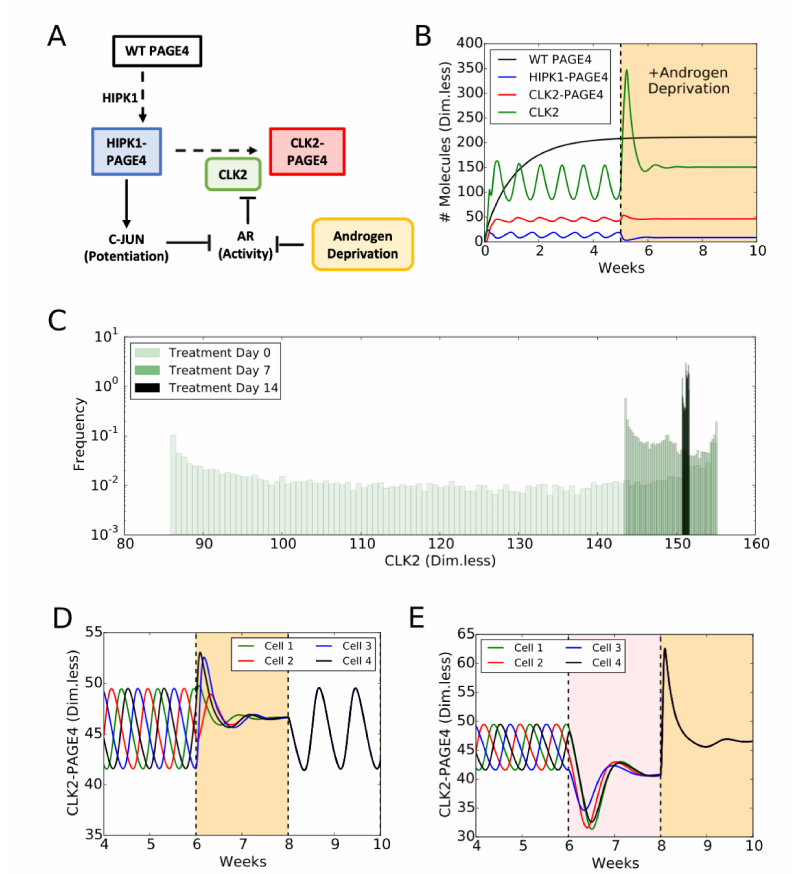
Figure 5. PAGE4 conformational switching gives rise to cell phenotypic oscillations which are suppressed by Androgen Deprivation treatments. ( A ) The PAGE4 phosphorylation circuit and its connection with androgen receptor (AR) activity. Wild-type PAGE4 is double-phosphorylated at two residues by HIPK1 kinase, and HIPK1-PAGE4 is hyper-phosphorylated by the CLK2 kinase. CLK2 is downregulated by AR, which in turn is inhibited by HIPK1-PAGE4 via the intermediates c-Jun. Androgen Deprivation treatment is introduced as an inhibitory signal on AR activity. ( B ) Temporal dynamics of the cellular level of WT PAGE4, HIPK1-PAGE4, CLK2-PAGE4 and CLK2. Without androgen-deprivation therapy (ADT), the oscillatory behavior exhibits a period of approximately one week (left area without shading). ADT (orange-shaded area) quenches oscillations within approximately two weeks. WT PAGE4, HIPK1-PAGE4, CLK2-PAGE4 and CLK2 are represented in dimensionless units. ( C ) Distribution of CLK2 intracellular levels in a simulated cohort of 10,000 prostate cancer (PCa) cells. In the absence of treatment, the distribution of CLK2 levels is broad (“Day 0” case). One week of treatment considerably shrinks the distribution (“Day 7” case). After two weeks of treatment, all cells have a similar level of CLK2 (“Day 14” case). ( D ) Temporal dynamics of CLK2-PAGE4 in four initially unsynchronized cells under intermittent ADT. The orange shading represents the periods of ADT. ( E ) Temporal dynamics of CLK2-PAGE4 in four initially unsynchronized cells under the BAT. The pink and orange shadings represent the periods of AR overexpression and ADT, respectively. Reproduced from [35] with